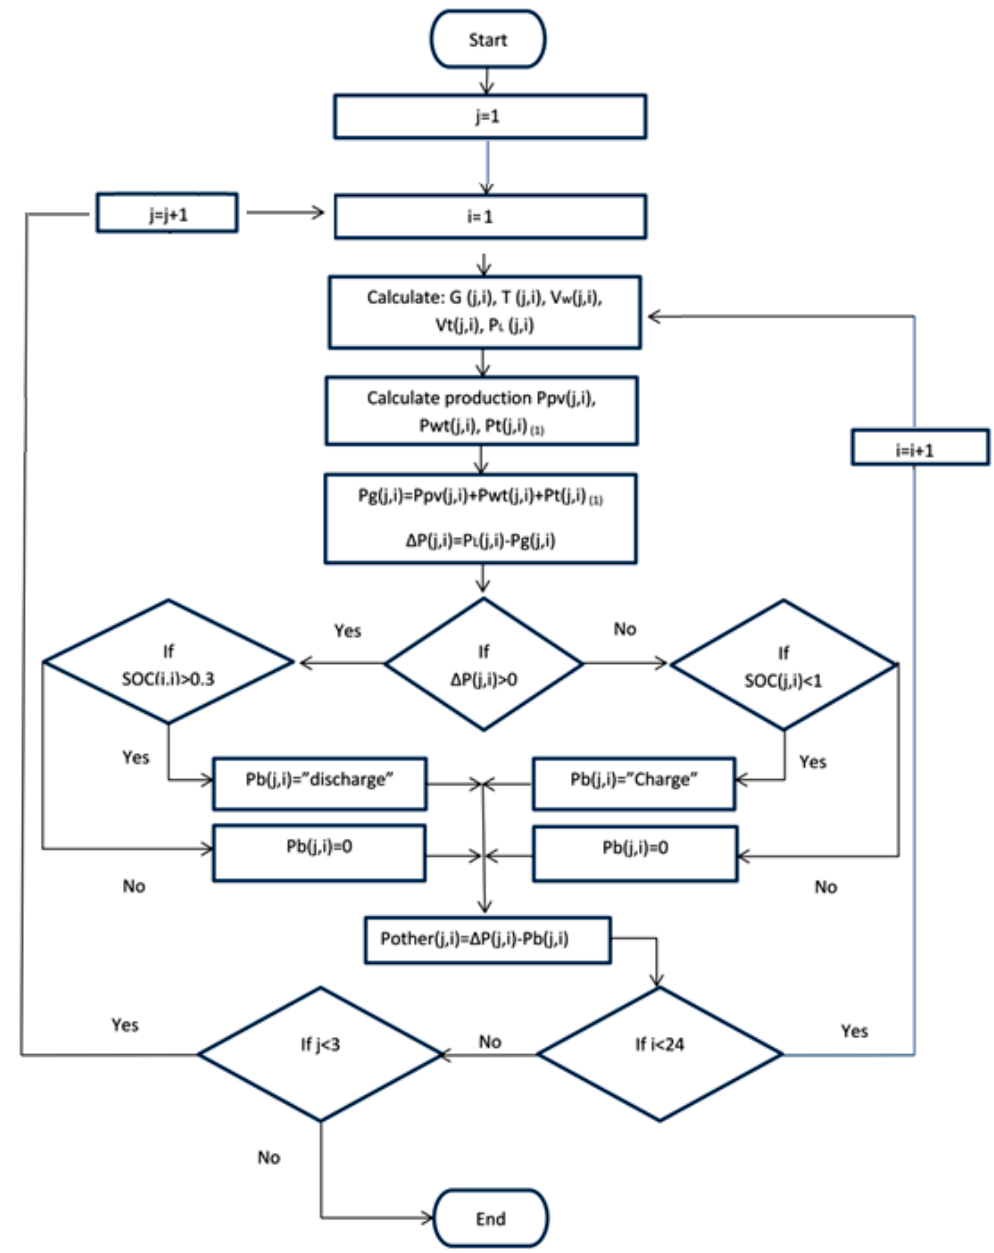
Figure 2. The optimization algorithm of the hybrid autonomous microgrid. Table 1. Explanation of symbols used in the flow chart of Figure 2.